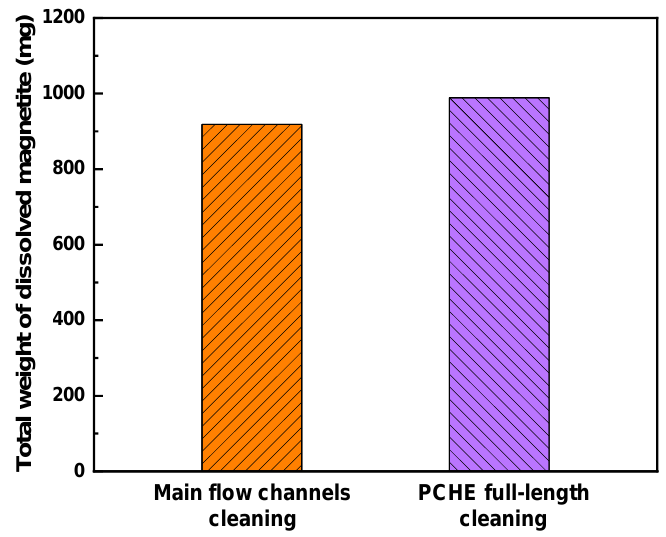
Figure 11. Total weight of magnetite dissolved from each cleaned PCHE.